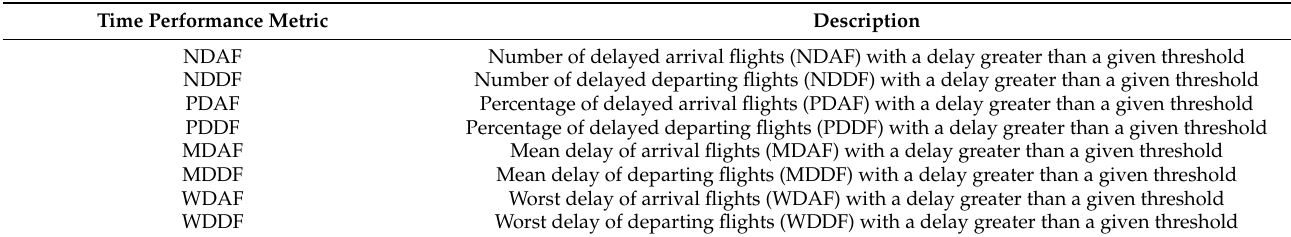
Table 5. Time performance metrics.